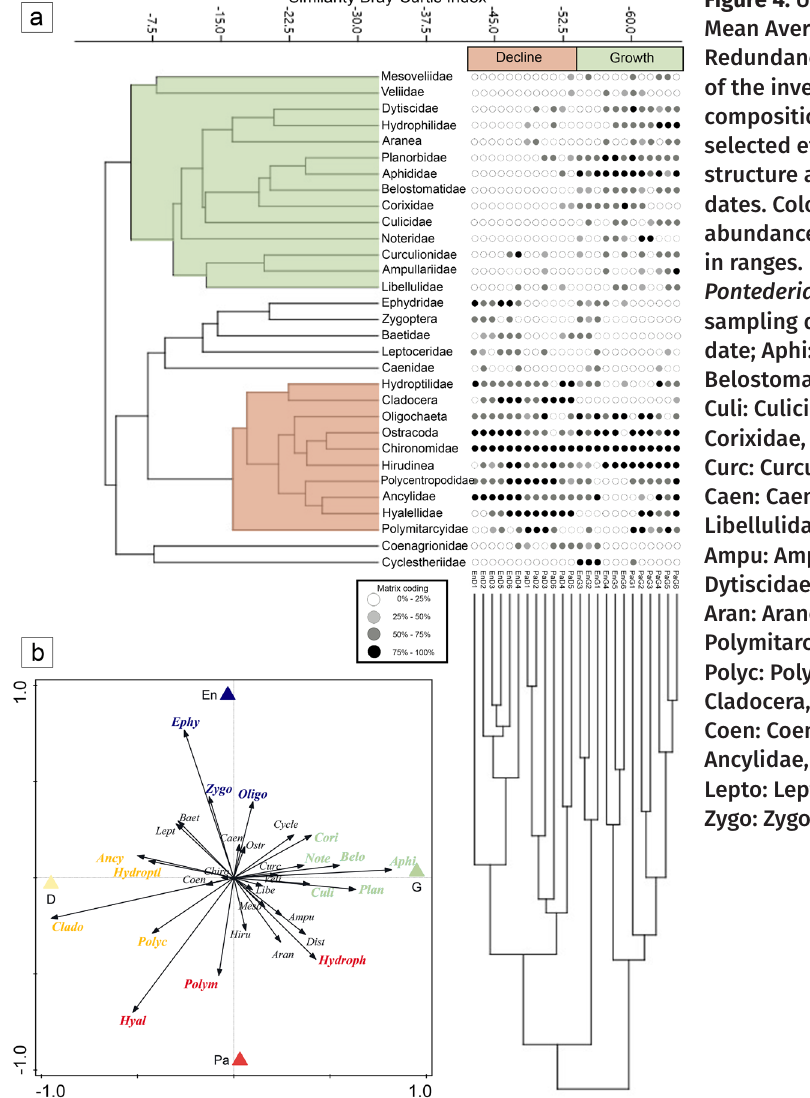
Figure 4. Unweighted Pair Group Mean Averages (UPGMA) (a) and Redundancy analysis (RDAs) (b) of the invertebrate community composition in relation to the selected effects, vegetation structure and contrasting sampling dates. Colored dots indicate abundance proportions